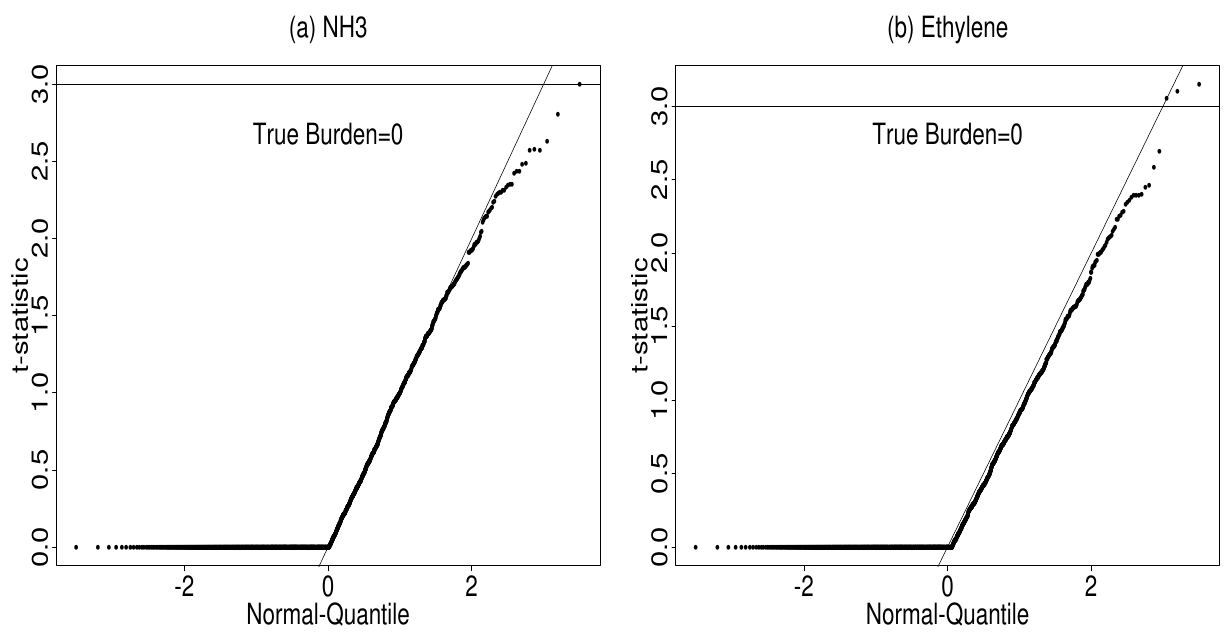
Figure 3 . Q-normal Plots of the T-statistic for NH3 and Ethylene, When the True Gas Burden is